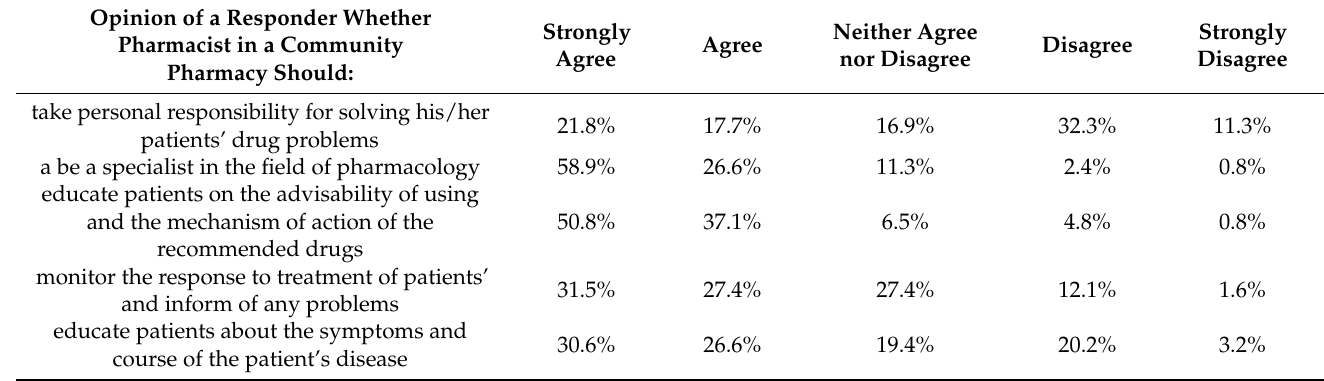
Table 3. Nurses’ current experience in the field of cooperation with a pharmacist in general ( n =